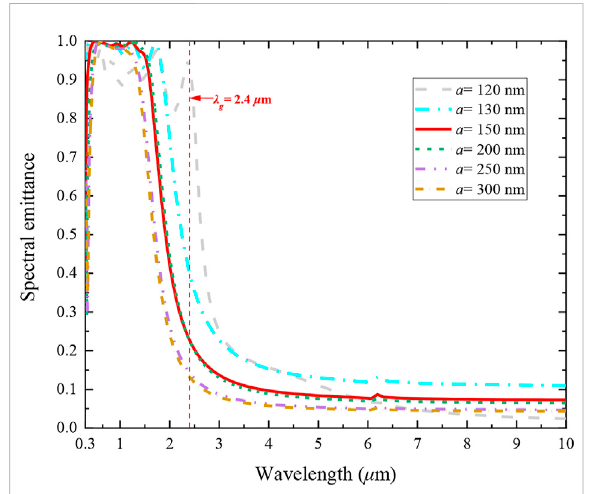
FIGURE 9 Variation of structure spectral emittance with period ( a = 120 nm, 130 nm, 150 nm, 200 nm, 250 nm, 300 nm) for fi xed composite structure with other parameters ( r = 60 nm, d M